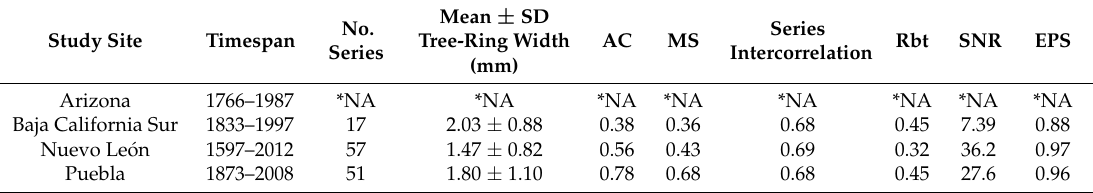
Table 2. Dendrochronological statistics corresponding to the raw tree-ring width data (mean; SD, standard deviation; AC, first-order autocorrelation) and the ring-width indices (MS, mean sensitivity; series intercorrelation; Rbt, mean correlation between trees; SNR, signal-noise ratio; and EPS, Expressed Population Signal). Values were calculated for the common period